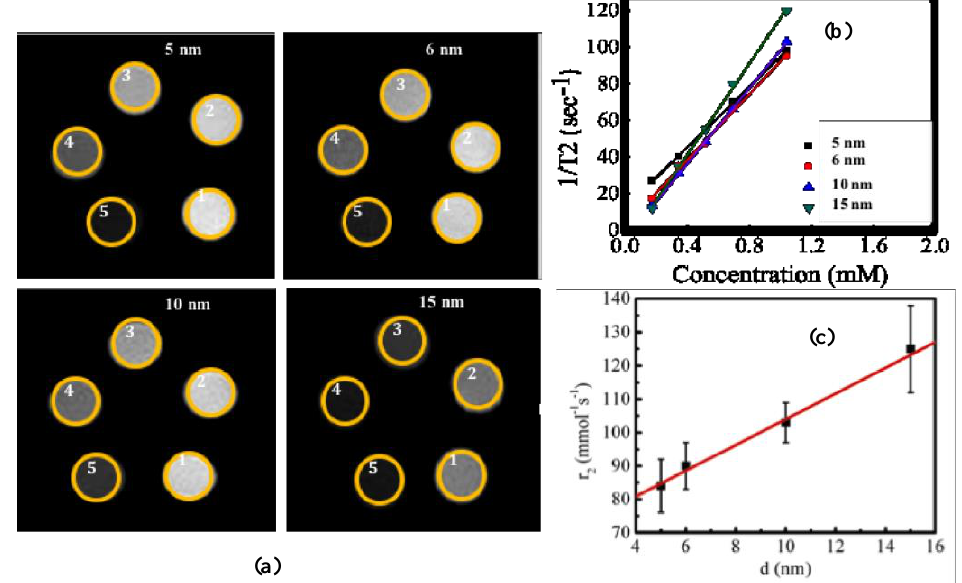
Figure 13. MRI data of CS-coated MnFe 2 O 4 spinel ferrites nanoparticles. ( a ) Images acquired at TE of 14 ms (particle sizes of 5, 6, 10, and 15 nm) for CS-coated MnFe 2 O 4 spinel ferrites nanoparticles with different values of concentrations (0.17, 0.34, 0.51, 0.68 and 1.03 mM) inside the five tubes in each image 1 to 5 represents lower to higher concentration of the nanoparticles in solution demonstrating contrast agents at different particle sizes. ( b ) Absolute R 2 (or 1/T 2 ) mapping images for particle sizes of 5, 6, 10, and 15 nm at different concentrations. ( c ) Nanoparticle size dependence of relaxivity ( r 2 ) of CS-coated MnFe 2 O 4 nanoparticles.